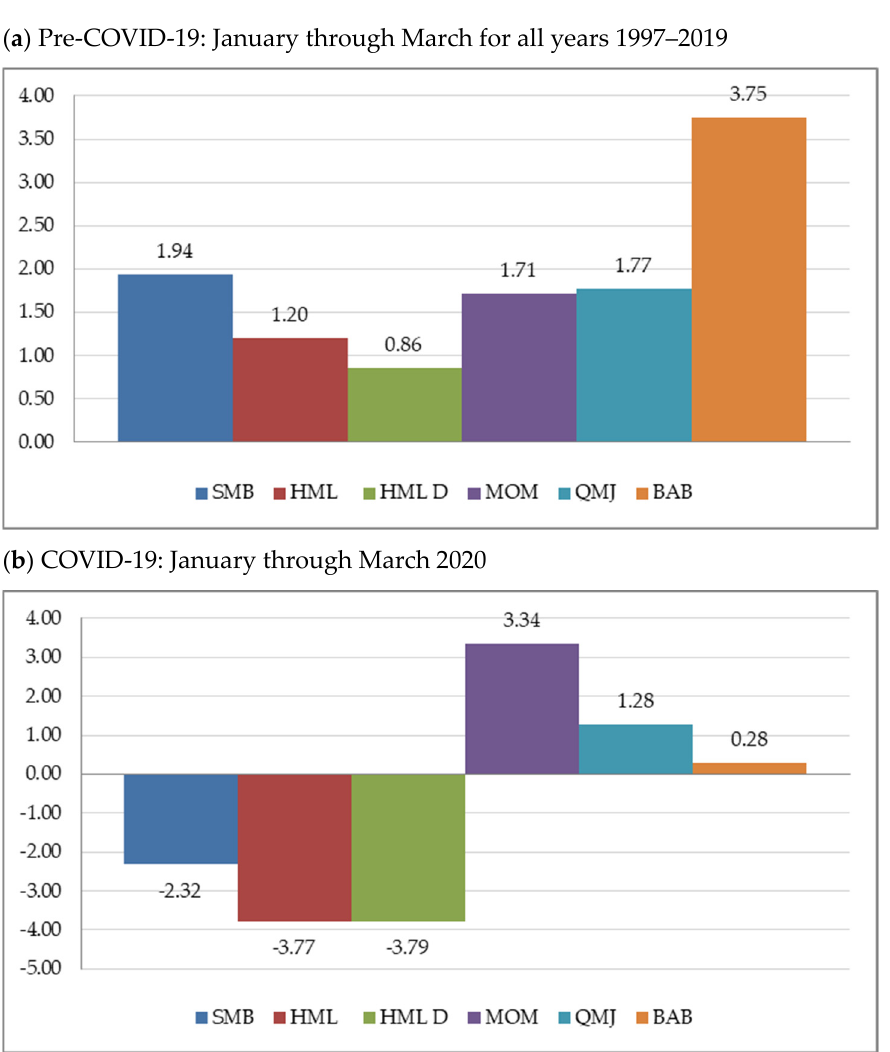
Figure 1. t -Statistics for the CAPM Alphas for the Risk Factors: Global Index. This figure displays the t -statistics for testing the significance of the intercept from a regression of each alternative risk factor on the excess market return for the global international stock market index. See notes in Table 1 for the definition of the factos. ( a ) shows the results when using monthly data for the first quarter of each of the years between 1997 and 2019, and ( b ) shows the results when using daily data for the subperiod affected by the first impact of the COVID-19 pandemic from January to March